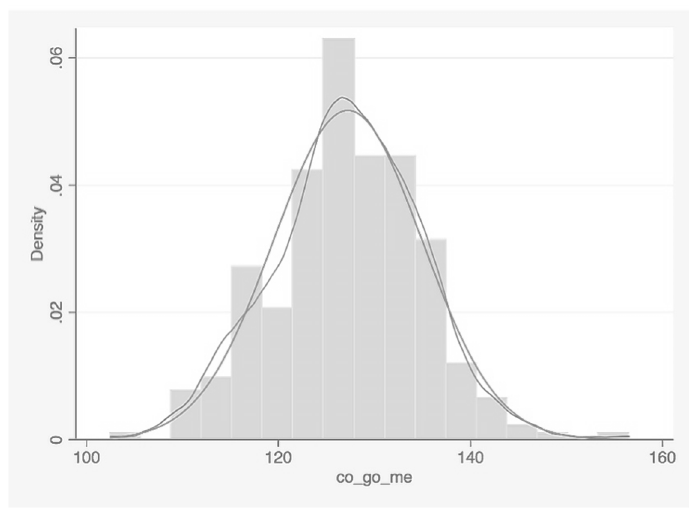
Figure 3. Graph describing the distribution of the CoGoMeˆ in the study population (N = 290; mean ± SD = 127.2° ± 7.7° [CI 95% 112.1°–142.3°]).